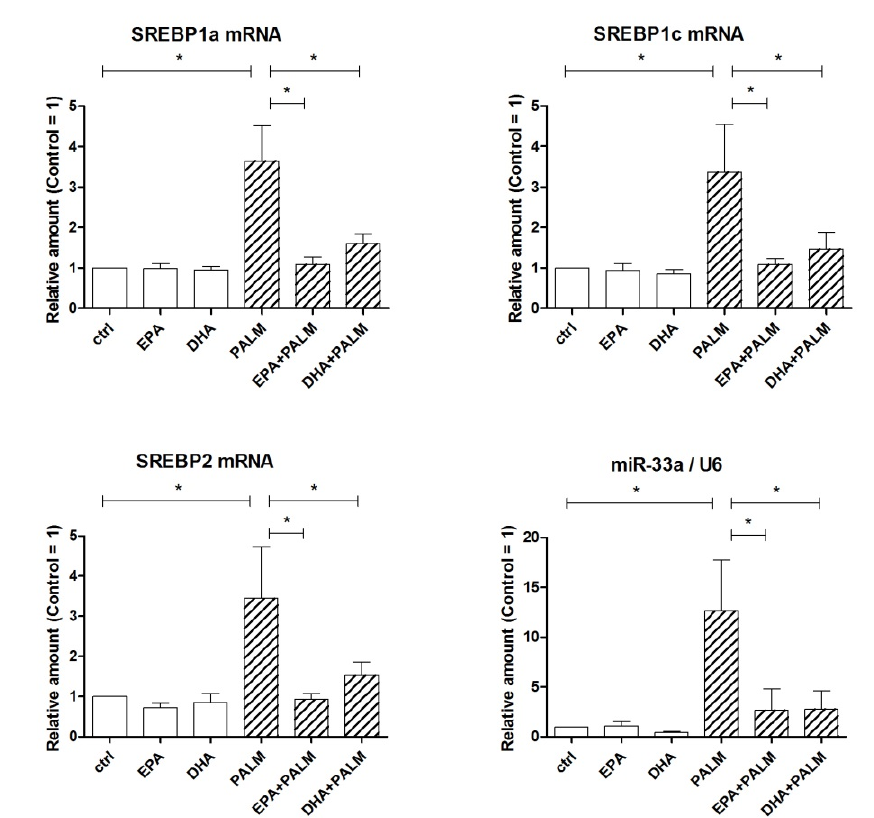
Figure 2. Effect of n-3 PUFAs on the expression of SREBP genes in H9c2 cells exposed to palmitate. H9c2 cells were incubated in the presence or absence of fatty acids as described in the legend of Figure 1. After a 16 h incubation, H9c2 cells were analyzed by RT-PCR for the relative amount of SREBP1a mRNA, SREBP1c mRNA, SREBP2 mRNA, and miR-33a. Differences are indicated with * for p < 0.05.